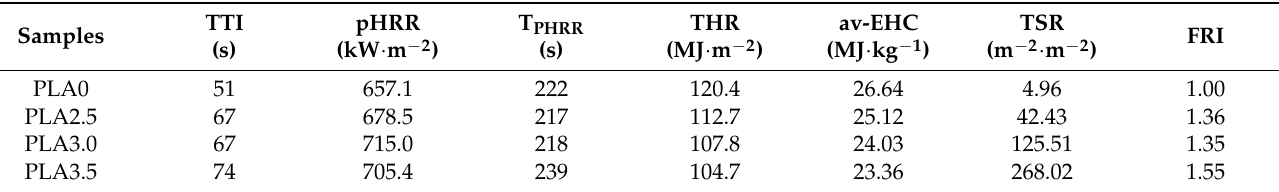
Figure 2. ( a ) HRR and ( b ) THR curves of PLA/MKF/NTPA biocomposites. Table 2. CCT data of PLA/MKF/NTPA Table 2. CCT data of PLA/MKF/NTPA biocomposites.